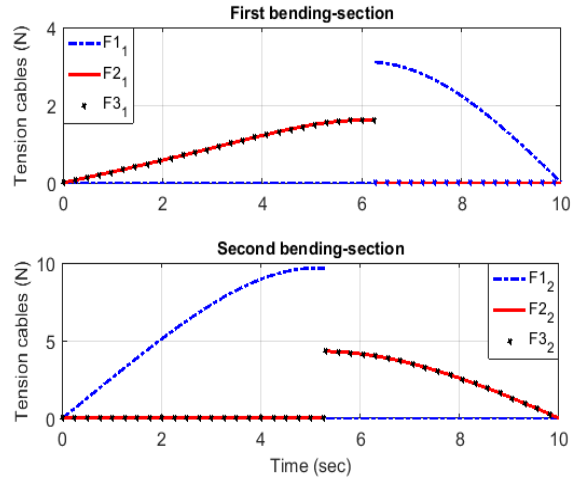
Figure 13. Evaluation of tensions applied on the cables for the dynamic NMPC-PSO For comparison, the proposed NMPC-PSO based on the dynamic model has achieved a good performance in trajectory tracking accuracy, smoothness in control signals, and absence of oscillations in the state variables compared to the kinematic one. In contrast, the proposed NMPC-PSO based on the kinematic model took less computation time and was easier in formulation than the dynamic one.